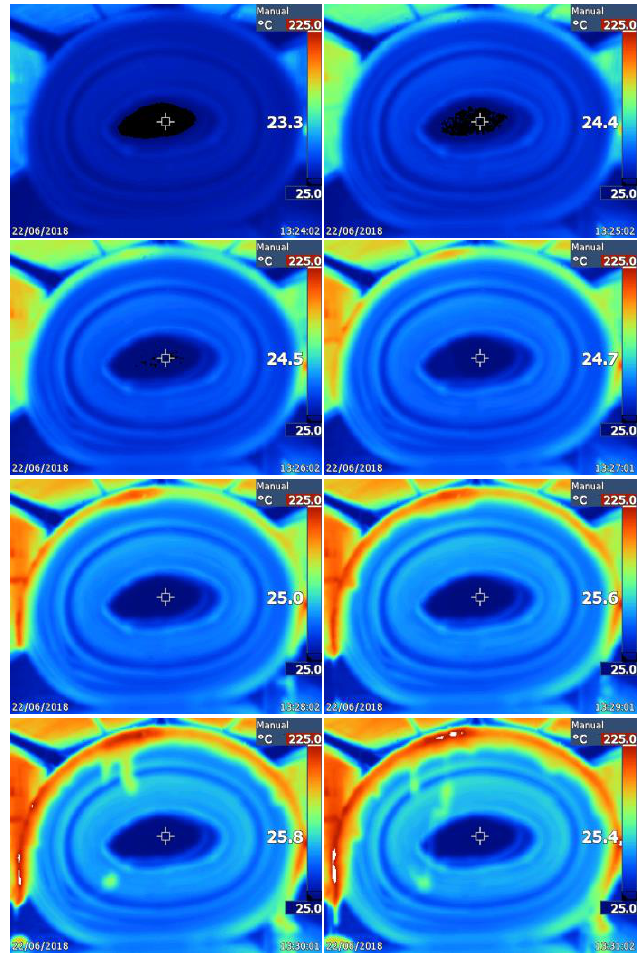
Figure 17. Thermal images of the roll under heating. Elapsed time between images was 1 min. Total test time was 8 min.